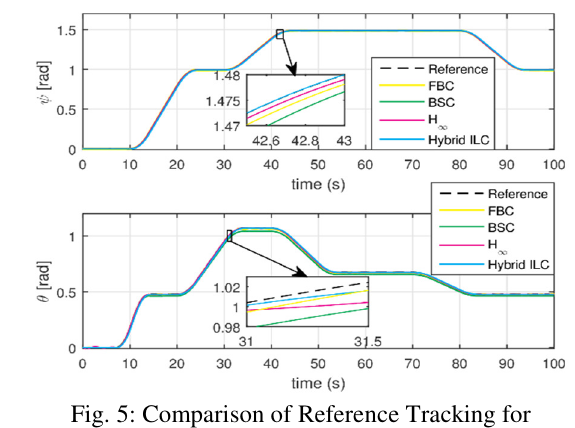
Fig. 5: Comparison of Reference Tracking for Different Controllers with the Hybrid ILC